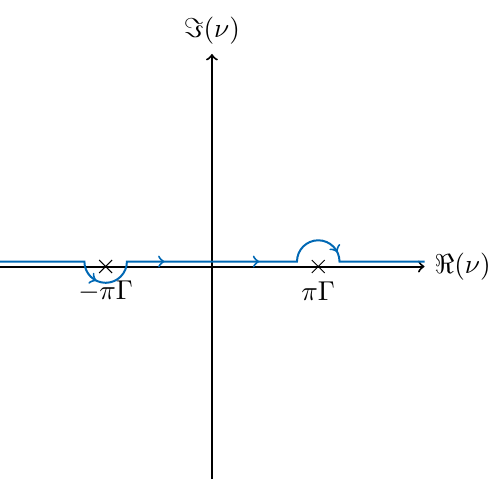
Figure 1 . Integration contour for the six-gluon BFKL integral at (cid:12)nite coupling. Here and in the following (cid:12)gures indicating di(cid:11)erent integration contours for the six-and seven-gluon